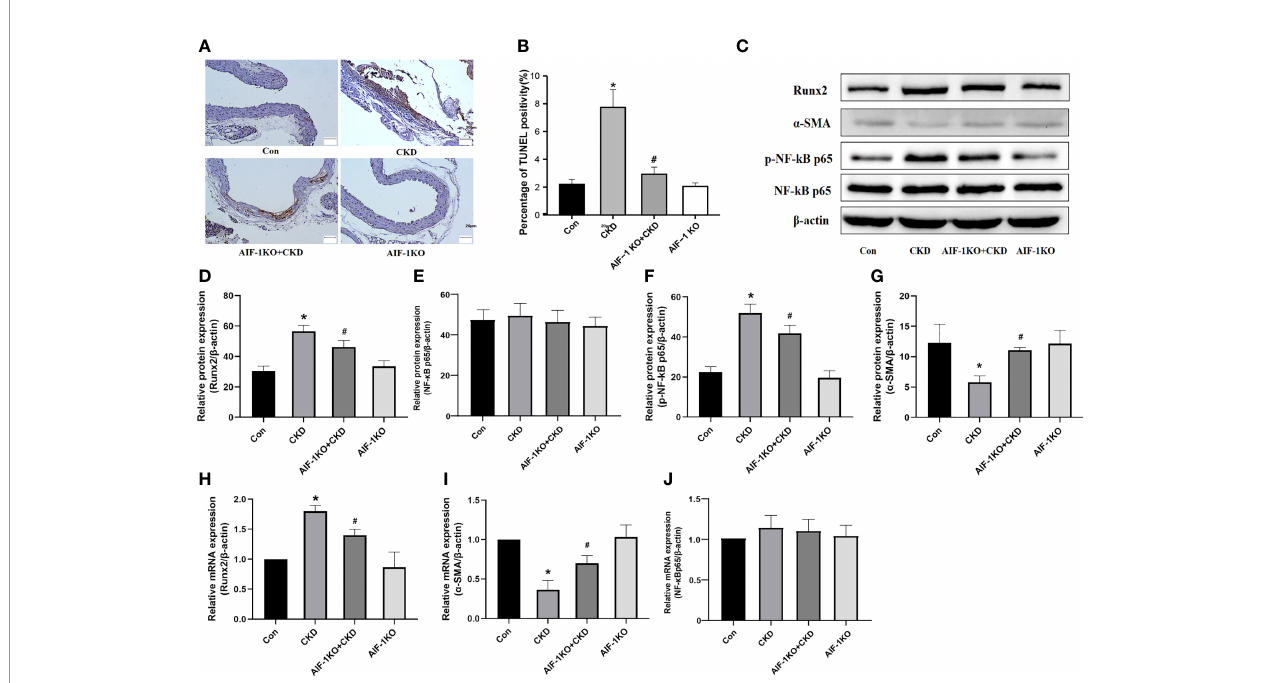
FIGURE 5 | Cell apoptosis in the vascular tissue using TUNEL staining (200X) (A, B) . Western blot and PCR analysis (C – J) . (n=6) (*P<0.05, Control group vs. CKD group; # P<0.05, CKD group vs. AIF-1KO+CKD group).